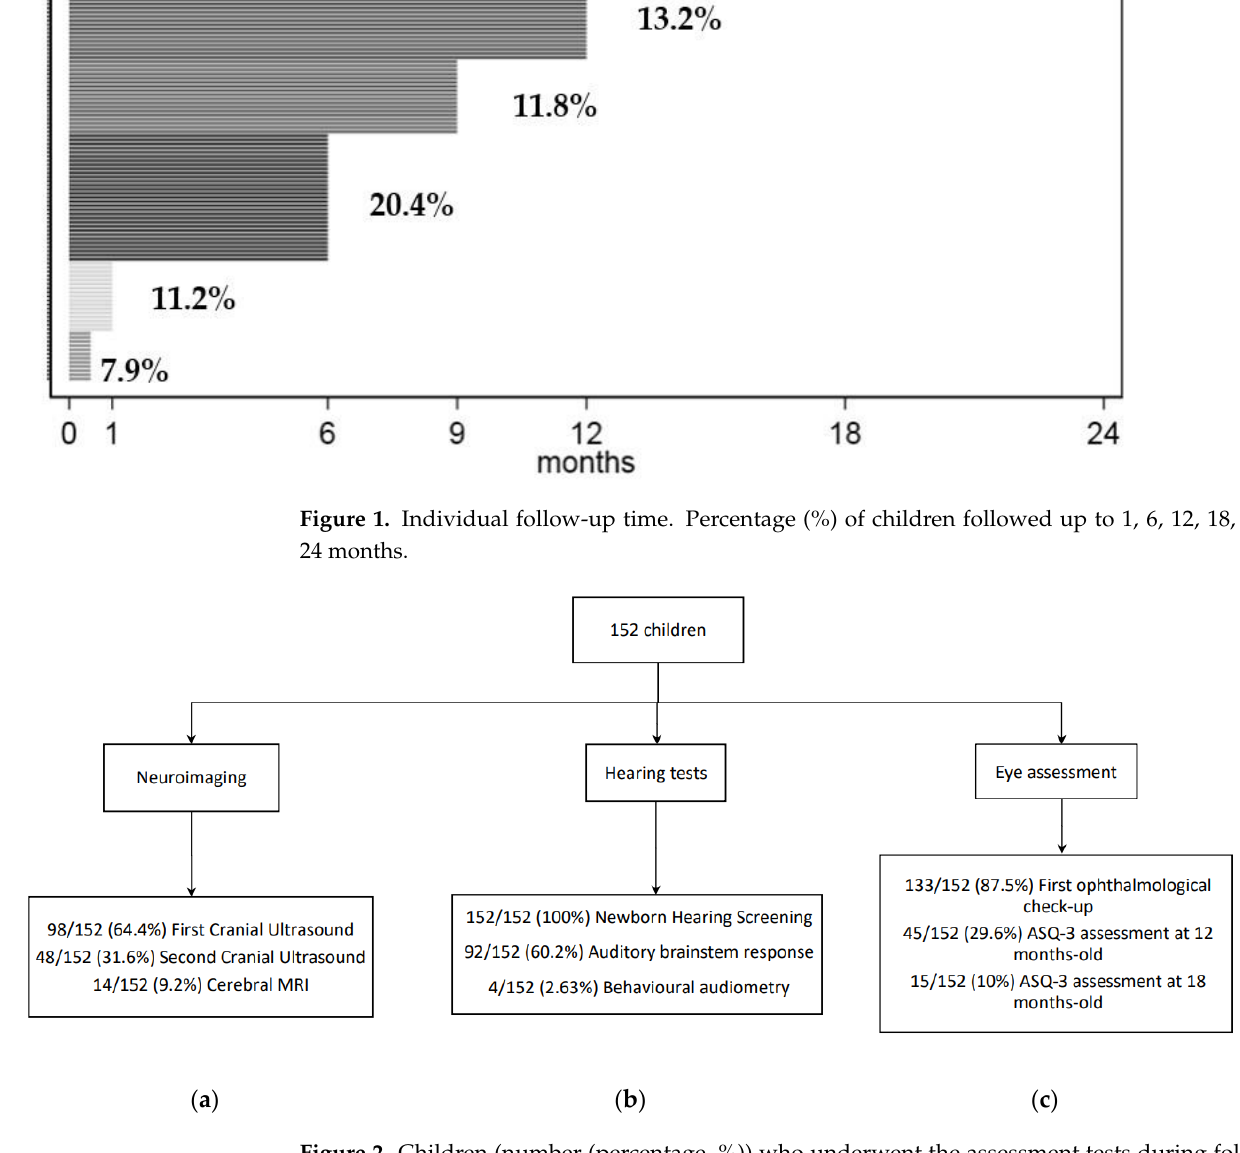
Figure 2. Children (number (percentage, %)) who underwent the assessment tests during follow- up. ( a ) Proportion (percentage) of children who underwent the neuroimaging tests. ( b ) Proportion (percentage) of children who underwent hearing tests. ( c ) Proportion (percentage) of children whose ASQ-3 assessment was collected and whose first ophthalmological check-up was done.